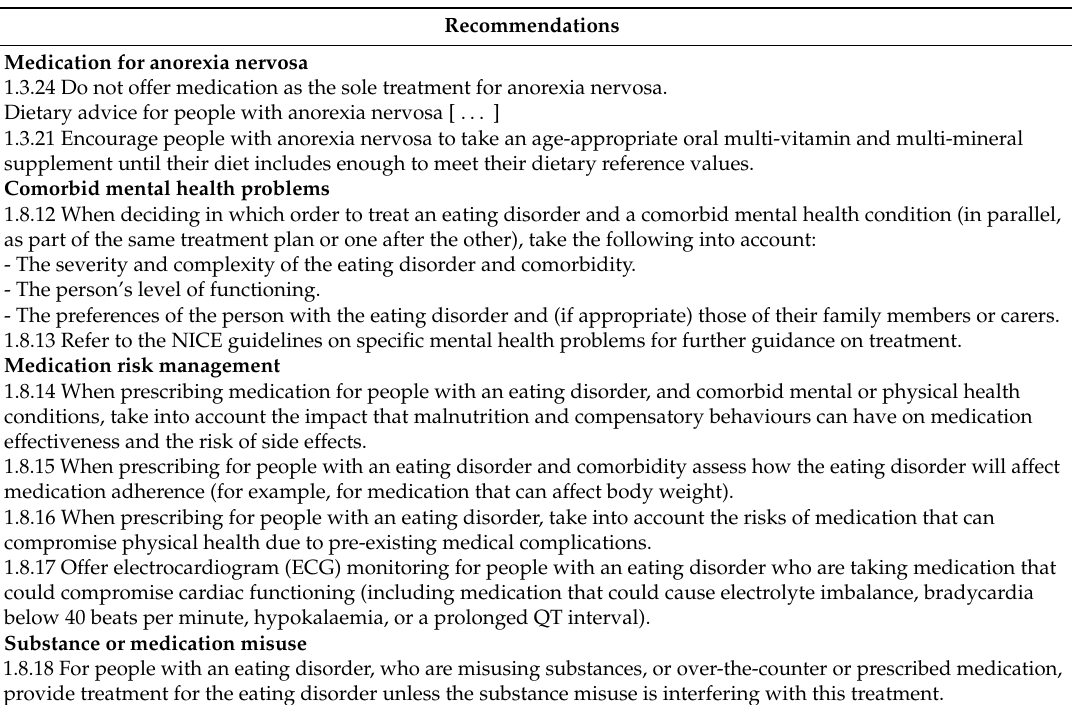
Table 1. Extract from the National Institute for Health and Care Excellence (NICE) recommendations [4] for medication in anorexia nervosa (chapter 1.3) and eating disorders in general including anorexia nervosa (chapter